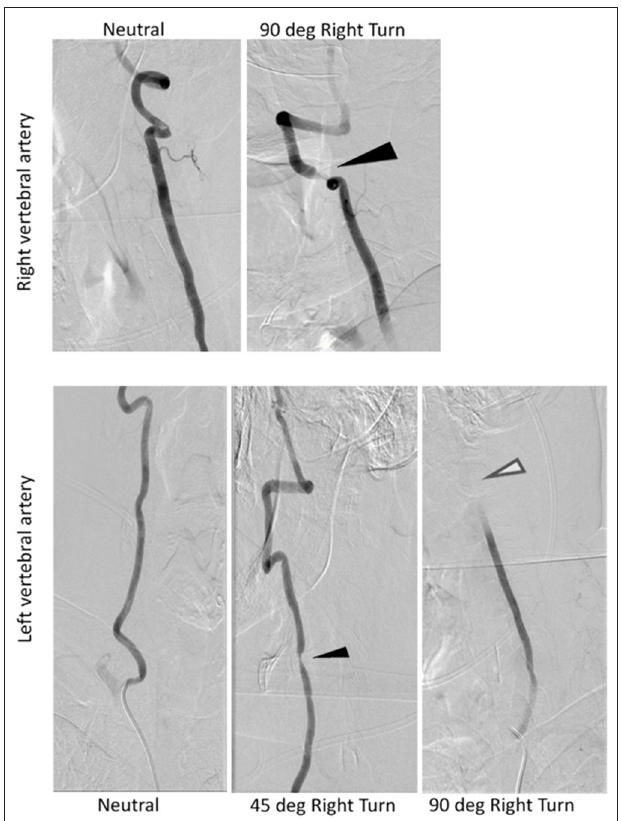
FIGURE 3 | Radiograph evidence confirming severe stenosis of right and left vertebral arteries during rightward head rotation. Dark arrows reflect partial stenosis, white arrow reflects absent perfusion from complete